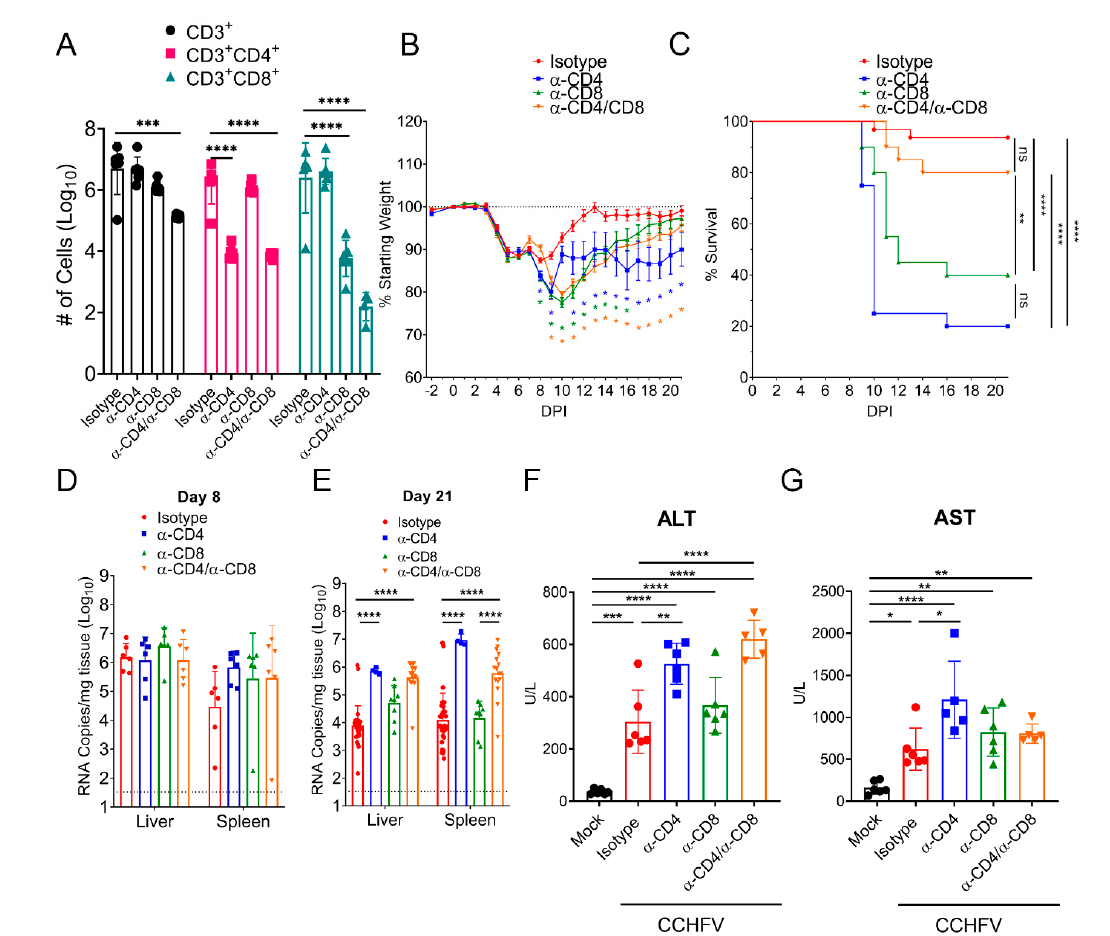
Figure 4. T-cells are required for survival following CCHFV infection. IFNAR − / − mice were treated with antibodies to deplete CD4 + , CD8 + , or both CD4 + and CD8 + cells on day − 2, +3, +10, and +17 relative to CCHFV challenge. ( A ) On day 8 PI, depletion efficacy was evaluated in a subset of mice by flow cytometry to enumerate number of CD3 + , CD3 + CD4 + , or CD3 + CD8 + T-cells in the liver. N = 6 per group. p values calculated with two-way ANOVA with Tukey-s multiple comparisons test. ( B ) Following CCHFV challenge, mice were weighed daily and monitored for survival ( C ). n = 20–32 mice per group. ( B ) Error bars indicate standard error of measurement. Statistical test comparing isotype-treated mice with depleted mice was performed using a two-way ANOVA with Dunnett’s multiple comparison test. ( C ) Indicated statistical comparison between groups performed using Log-rank test with Bonferroni’s correction for multiple comparisons. ** p < 0.01, **** p <0.0001. ( D , E ) At indicated time-points PI, mice were euthanized and viral RNA in the liver or spleen quantified by qRT-PCR. Dashed line indicates limit of detection. Statistical comparison to isotype-treated mice performed using two-way ANOVA with Sidak’s multiple comparison test. ( F , G ) At day 8 PI, blood levels of alanine aminotransferase (ALT) and aspartate aminotransferase (AST) were evaluated. Indicated statistical comparisons performed using an ordinary One-way ANOVA with Tukey’s multiple comparison test. ns p > 0.05, * p < 0.05, ** p < 0.01, *** p < 0.001, **** p < 0.0001.